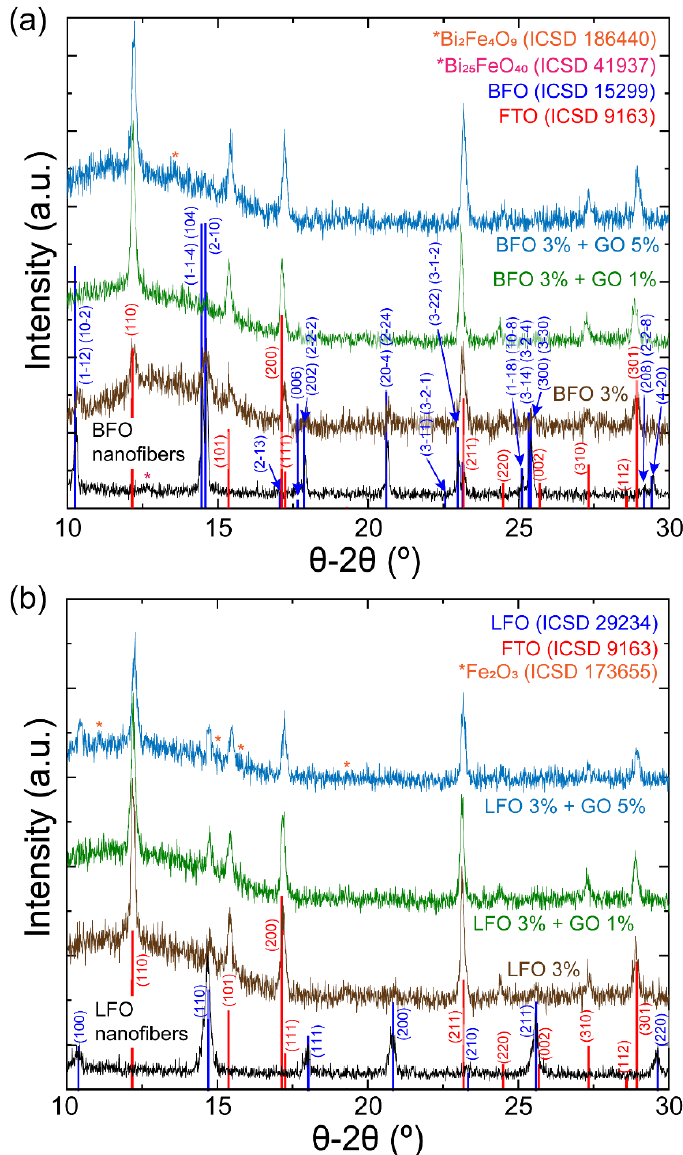
Figure 4. XRD patterns of ( a ) BFO nanofibers, BFO single-component layers and BFO nanofibers / rGO nanocomposite films; and ( b ) LFO nanofibers LFO single-component layers and LFO nanofibers / rGO nanocomposite films.